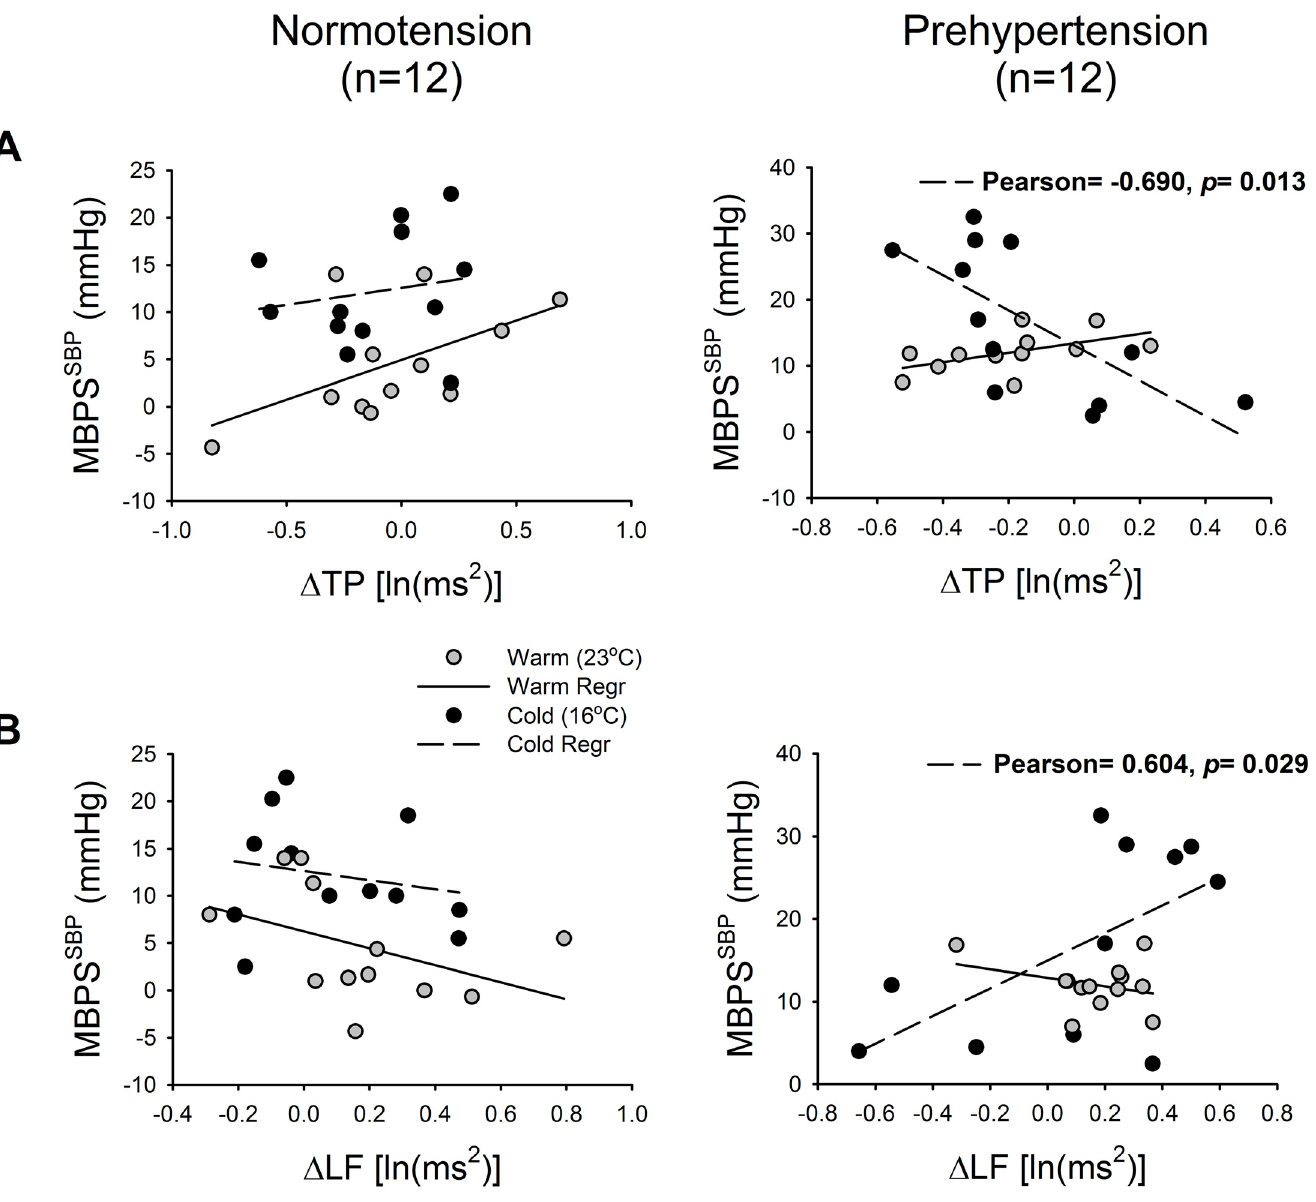
Fig 5. Relationship between the morning blood pressure surge (MBPS) and (A) the differential values of total power of HRV (TP) between early sleep and baseline and (B) low frequency (LF) between late sleep and early sleep. (A) The MBPS and the differential values of TP between early sleep and baseline appear to be highly negatively correlated relative to the change of TP between early sleep and baseline. (B) The relationship between MBPS and the change of LF shows a highly positive correlation: As the change of LF between late sleep and early sleep increases, the MBPS also increases. TP, total power of HRV; LF, low-frequency power of